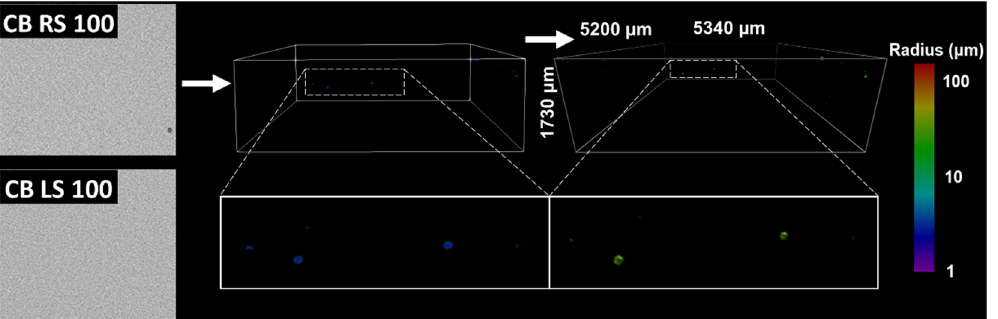
Figure 3. Pore network visualizations for 100 s − 1 cocoa butter samples. ( Left ) CT images slices, (Middle) raw 3D plots (blue) of CB RS 100 void and ( Right ) a 3D ball and stick plot of CB RS 100 pores and throats after MB analysis. No 3D visualizations for CB LS 100 were created because these networks have no voids.